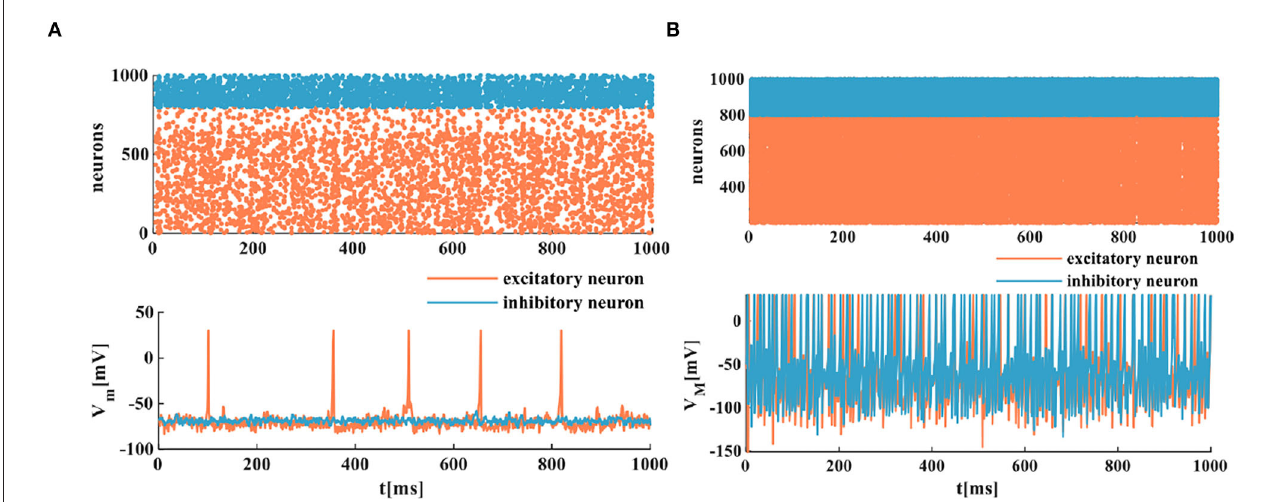
FIGURE 9 | The firing scatterplots of randomly coupled spiking neuron networks in the MIZH spiking model. (A) Asynchronous behaviors of the IZH spiking network. (B) Asynchronous behaviors of the MIZH spiking